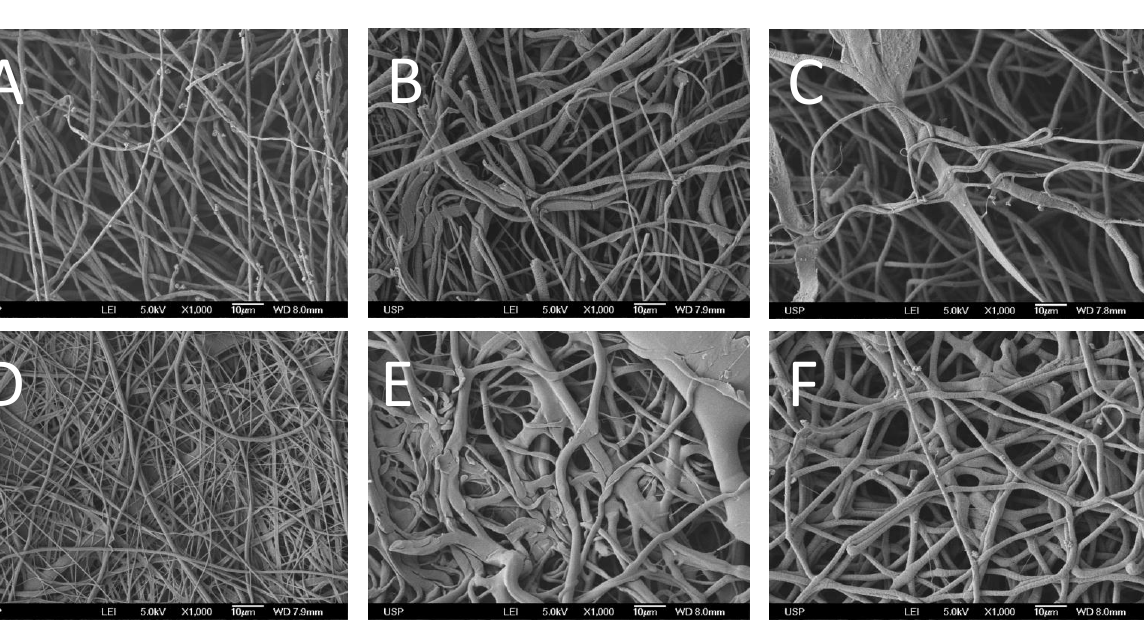
Figure 1. SEM images (×1000 magnification) of electrospun scaffolds: ( A ) PLLA; ( B ) PLLA after hydrolysis and collagen incorporation with EDC; ( C ) PLLA after aminolysis and collagen incorporation with GTA; ( D ) PLLA/collagen electrospun by blending; ( E ) PLLA/collagen electrospun by co-electrospinning and using HFP as the collagen solvent; and ( F ) PLLA/collagen electrospun by co-electrospinning and using acetic acid solution as the collagen